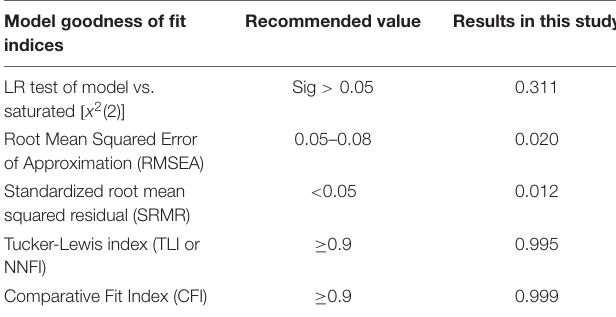
TABLE 5 | Statistical summary of model fit.